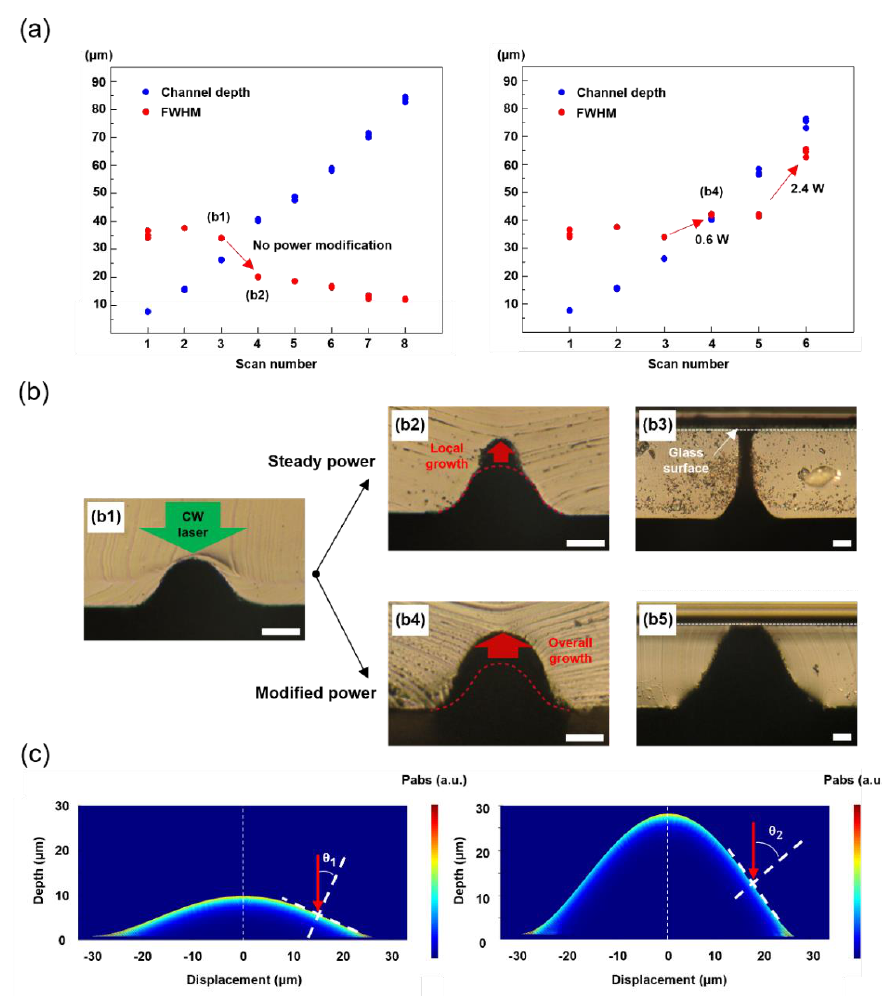
Figure 4. ( a ) Parametric studies of channel dimension created by BSS method according to scan numbers. ( b ) cross − section optical microscopy images of the microchannel, ( b1 ) PDMS channel by 3 times of BSS, ( b2 ) 4 times, ( b3 ) 9 times, ( b4 ) 4 times with power optimization, ( b5 ) 7 times with power optimization. Scale bars from ( b1 ) to ( b5 ): 20 µm. ( c ) FDTD simulation result of power absorption (P abs ).